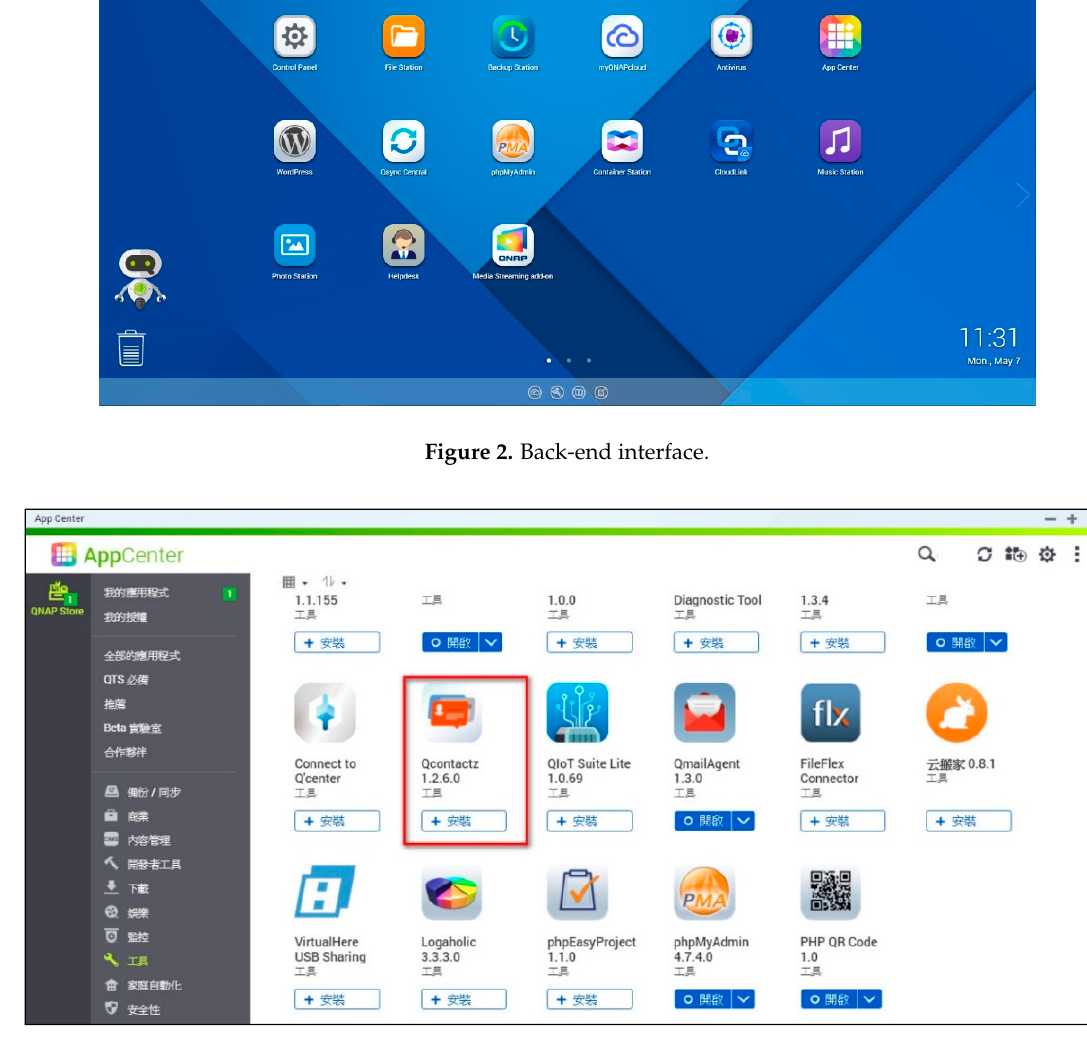
Figure 3. Downloadable free apps.